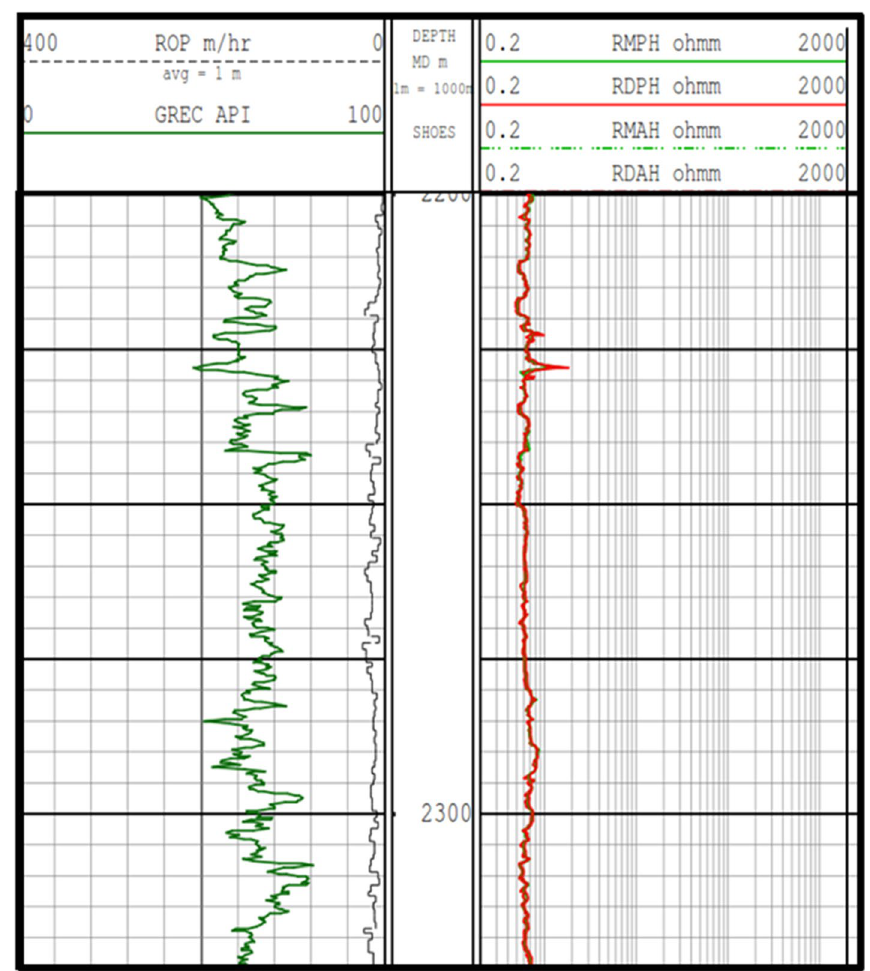
Fig. 9 Well_1 gamma ray and resistivity